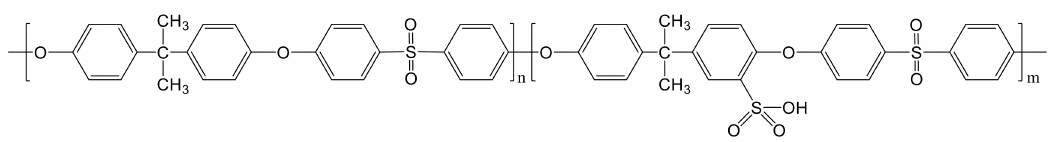
Figure 3. Molecular structure of sulfonated polysulfone (SPSf).